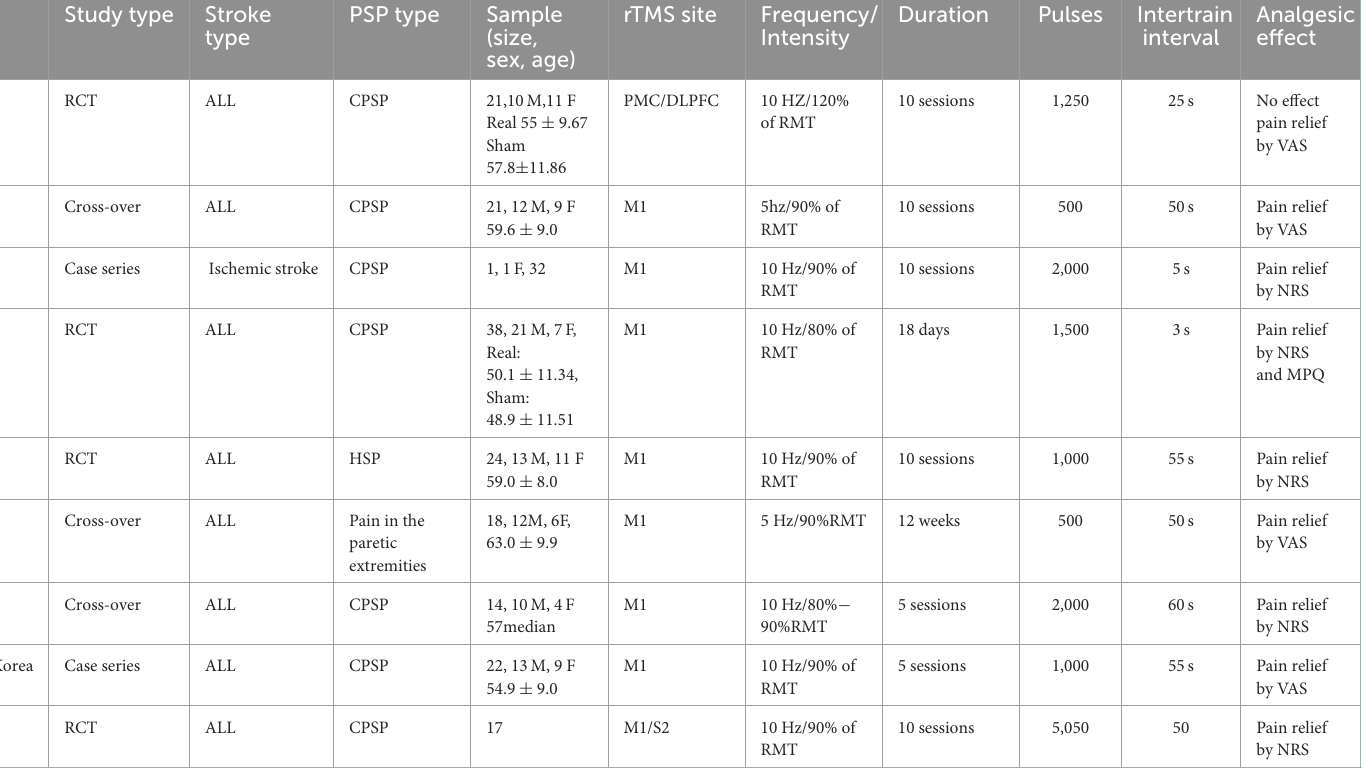
TABLE 1 Major findings of repetitive transcranial magnetic stimulation in post-stroke pain